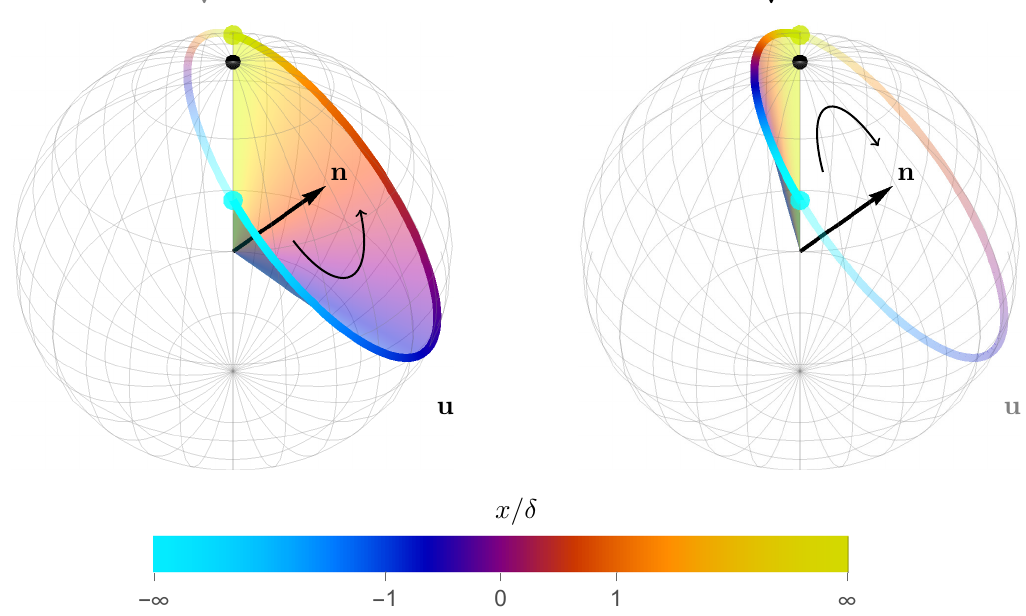
Figure 2 . Spin configuration for the one-soliton solution with the initial data (6.12) at fixed time t = 0 . Shown are the reference vector n x (blue and 0 (black dot), the local vacua m ±∞ at → ±∞ yellow dots), the vector n to the center of the rotation circle (black arrow), and the spin densities R , sweeping out a colored cone: at u ( x, t ) (left plot) and v ( x, t ) (right plot) as a function of x ∈ fixed x , u ( x, t ) and v ( x, t ) are drawn as a colored vector from the origin with their color indicating the value of x according to the legend underneath. To show how the images of u and v together form a circle on S 2 , a shadow of the image of v is plotted in the plot for u and vice versa. The curved arrow indicates the rotation direction of u (left plot) and v (right plot) when going from x = to x = −∞ ∞